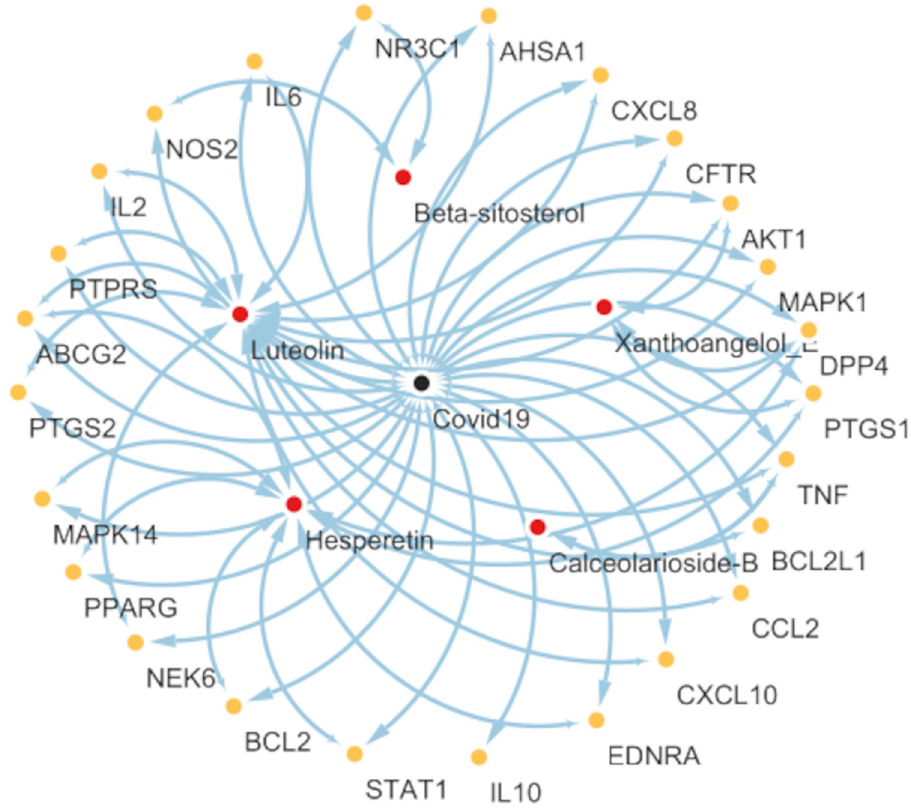
Fig 12. Medicinal compounds disease-target-network. Red dots represent the five-screened active phytochemicals and yellow dots represent the drug targets common between the proposed active phytochemicals and Covid19.